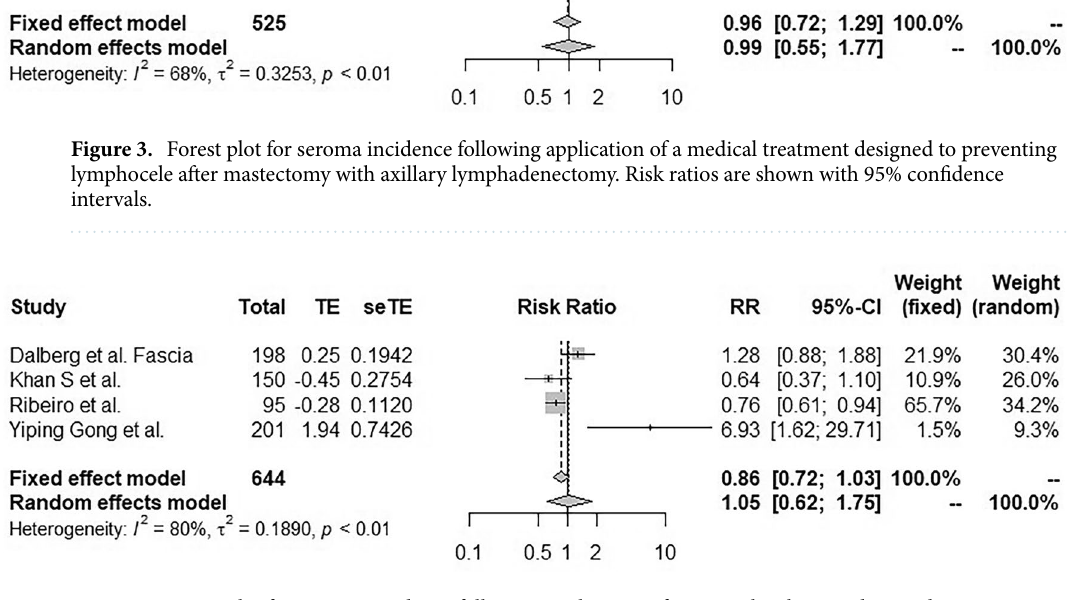
Figure 4. Forest plot for seroma incidence following application of a surgical technique designed to prevent lymphocele after mastectomy with axillary lymphadenectomy. Risk ratios are shown with 95% confidence intervals.